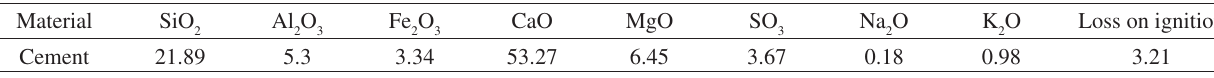
Table 1. Chemical and physical properties of Portland cement wt. (%). Material